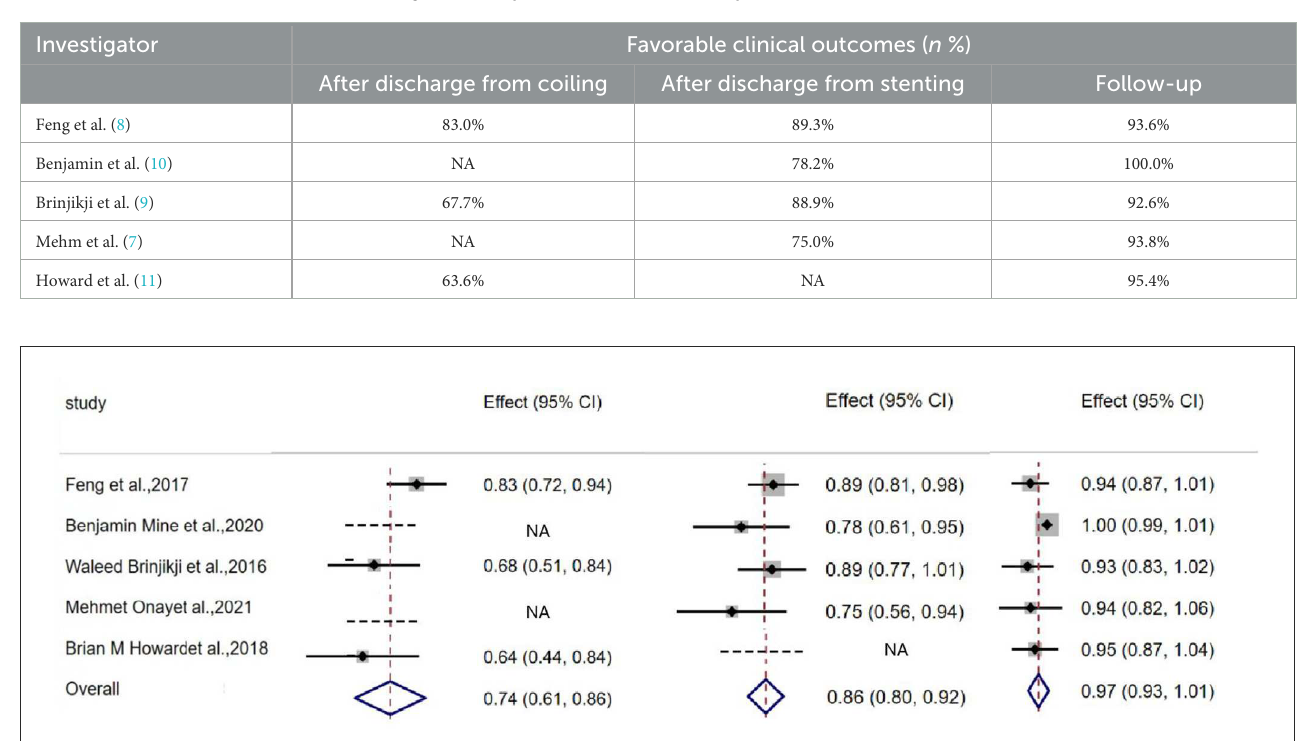
TABLE 5 Favorable clinical outcome immediately after both procedures and at follow-up.